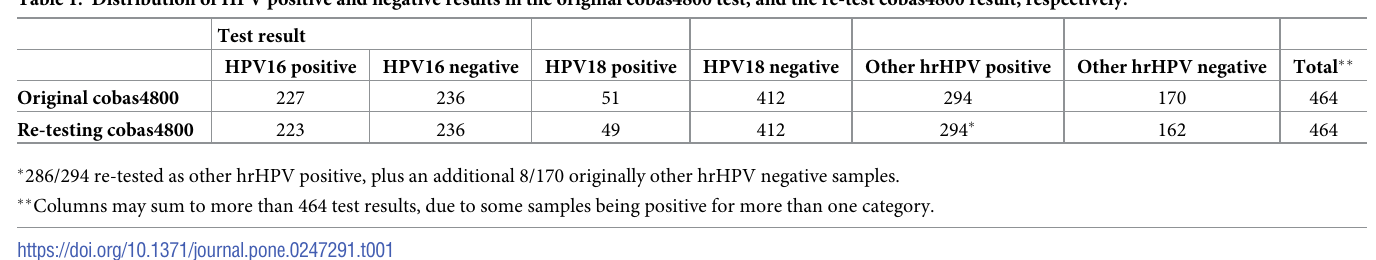
Table 2. Comparison of cobas 4800 and cobas 6800 sensitivity in the 464 pairs of valid samples from women with CIN3+.